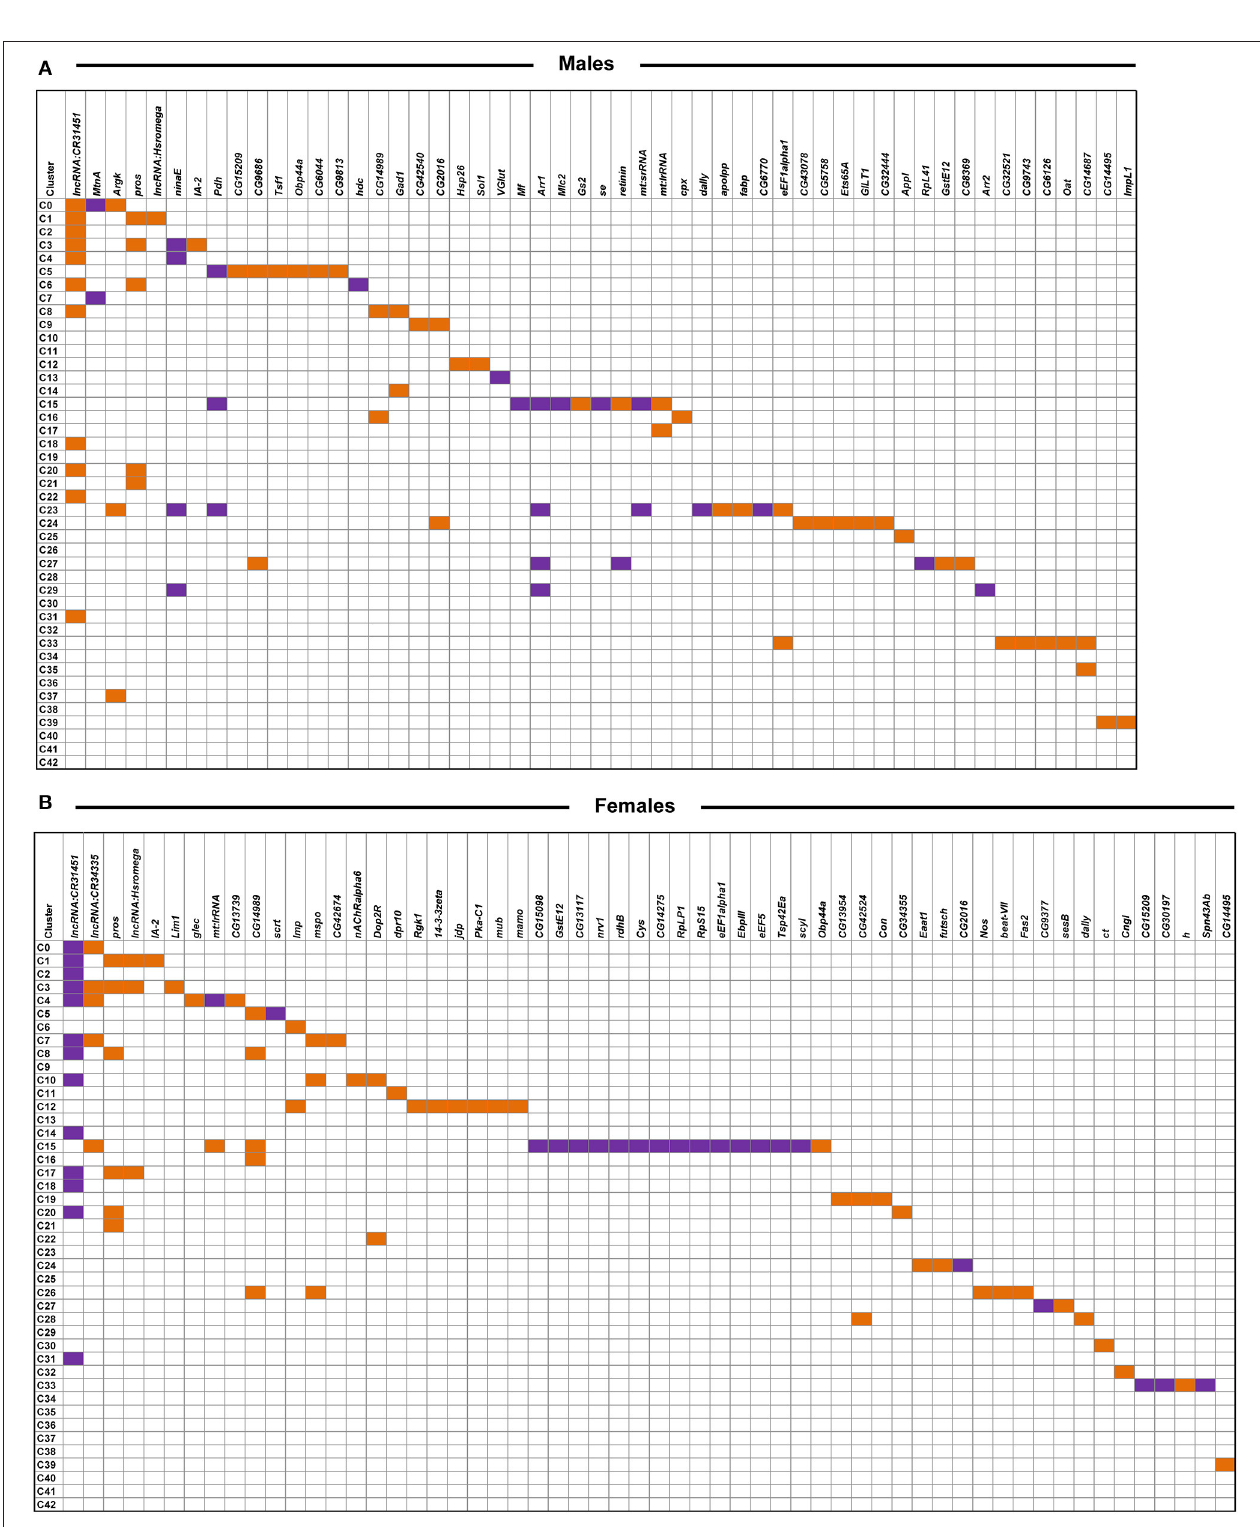
FIGURE 5 | Differentially expressed genes across clusters in males (A) and females (B) after developmental alcohol exposure. Differentially expressed genes are listed on the top (columns) and cell clusters are represented by the rows. Upregulated genes are indicated with orange and downregulated genes are indicated with purple. Differentially expressed genes are filtered at |log e FC| > 0.25 and a Bonferroni adjusted p < 0.05. Differentially expressed genes that survive a threshold of |log e FC| > 1.0 with a Bonferroni adjusted p < 0.05 are shown in Supplementary Figure 2 .